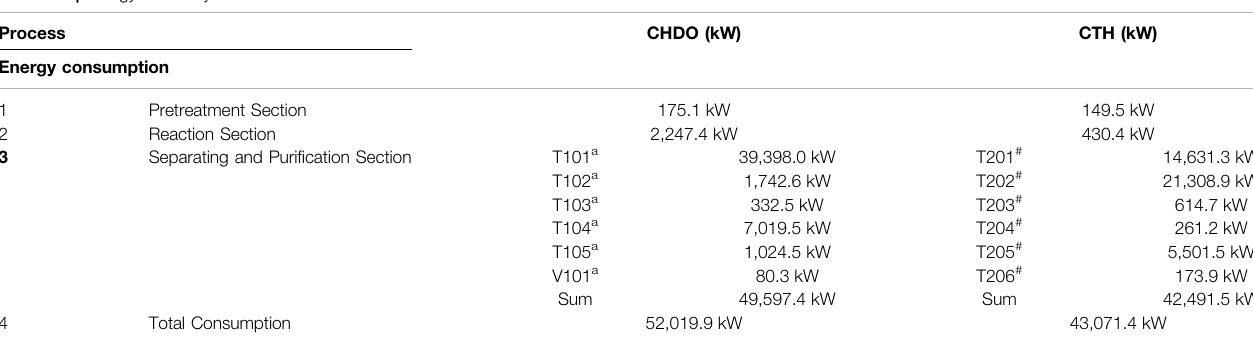
TABLE 4 | Energy summary of CHDO and CTH